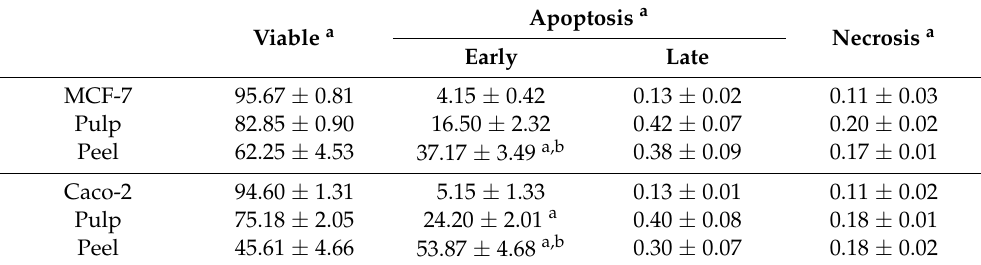
Table 5. Effects of the pulp and peel extracts of H. undatus on different stages of the cell-death process of MCF-7 and Caco-2 cells after 48 h of